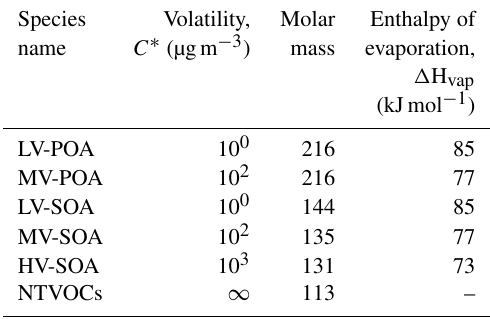
Table 1. Parameters of the species representing the evolution of BB OA in the framework of the simplified VBS